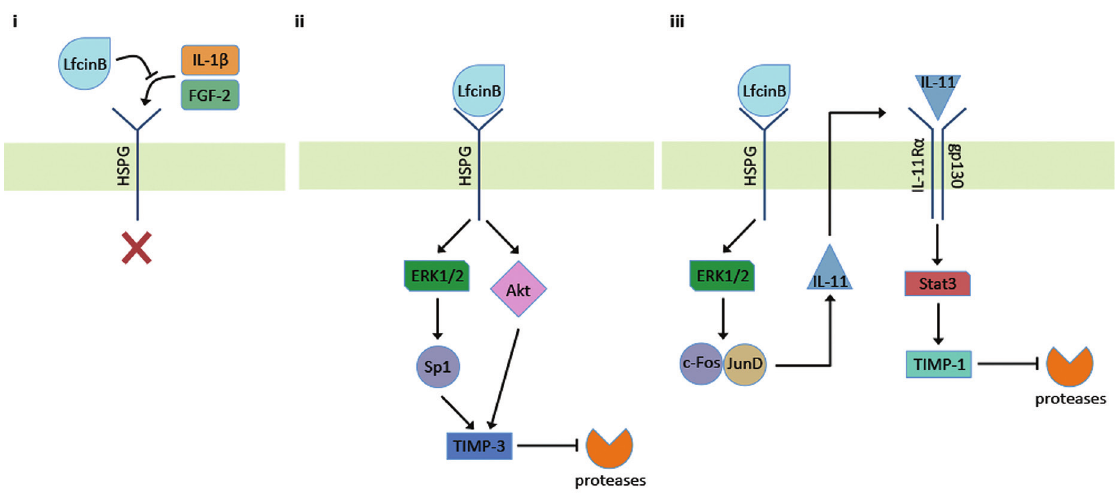
Figure 1 LfcinB uses multiple mechanisms to promote anti-catabolic and anti-inflammatory cellular processes. (i) LfcinB competes with IL-1 β and FGF-2 for HSPG binding. Failure of binding to their co-receptors results in inability of IL-1 β and FGF-2 to trigger downstream signal- ing. (ii) LfcinB-bound HSPG activates ERK-1/2 MAPK and Akt pathways. Active ERK-1/2 subsequently activates transcription factor Sp1